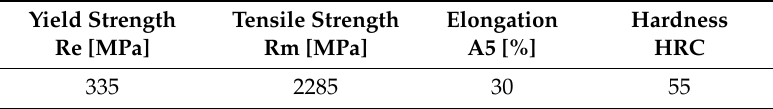
Table 2. Mechanical properties of hardened steel C45.